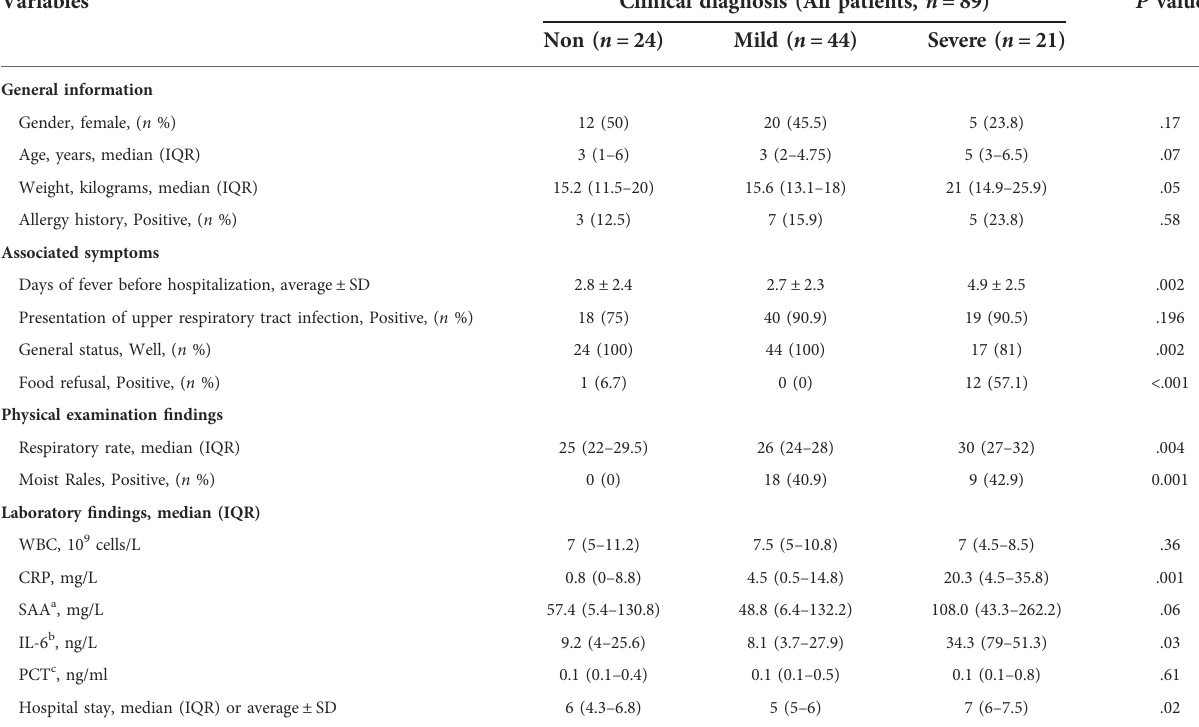
TABLE 3 Demographic and clinical characteristics of patients at baseline according to clinical diagnosis. Variables